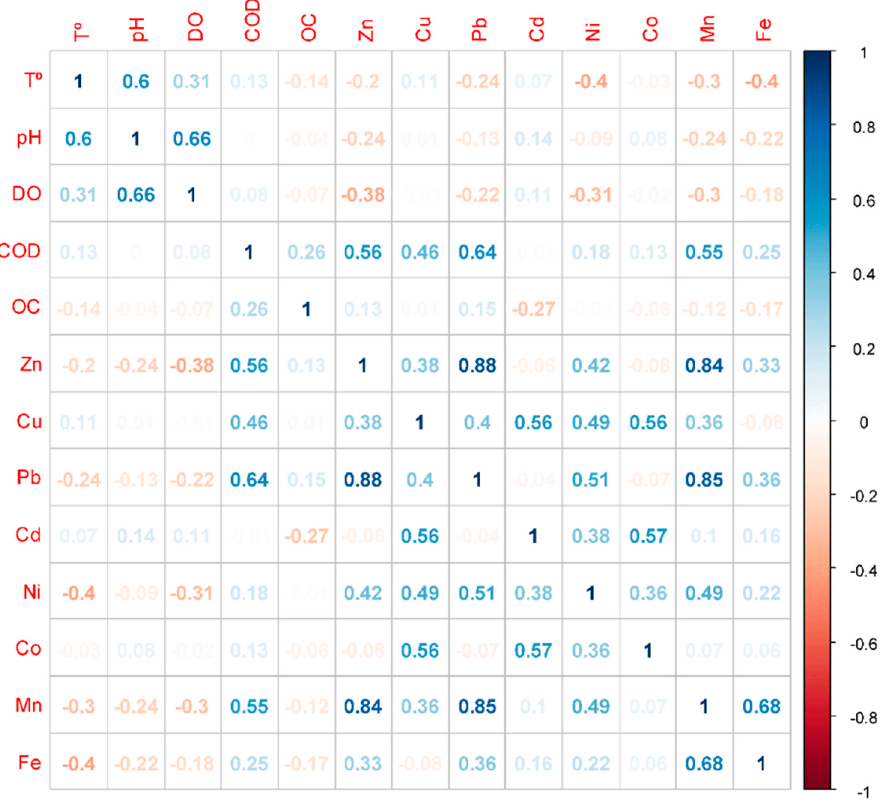
Figure 8. Pearson correlation coefficient.